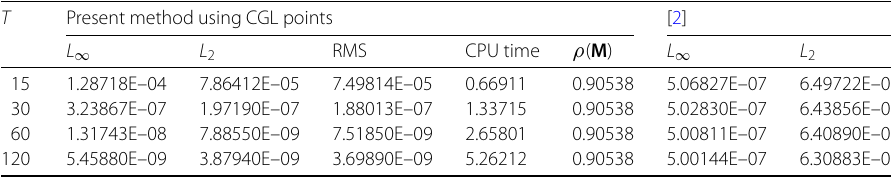
Table 1 Error norms and spectral radius for the solution of Example 1 in Case 1.1